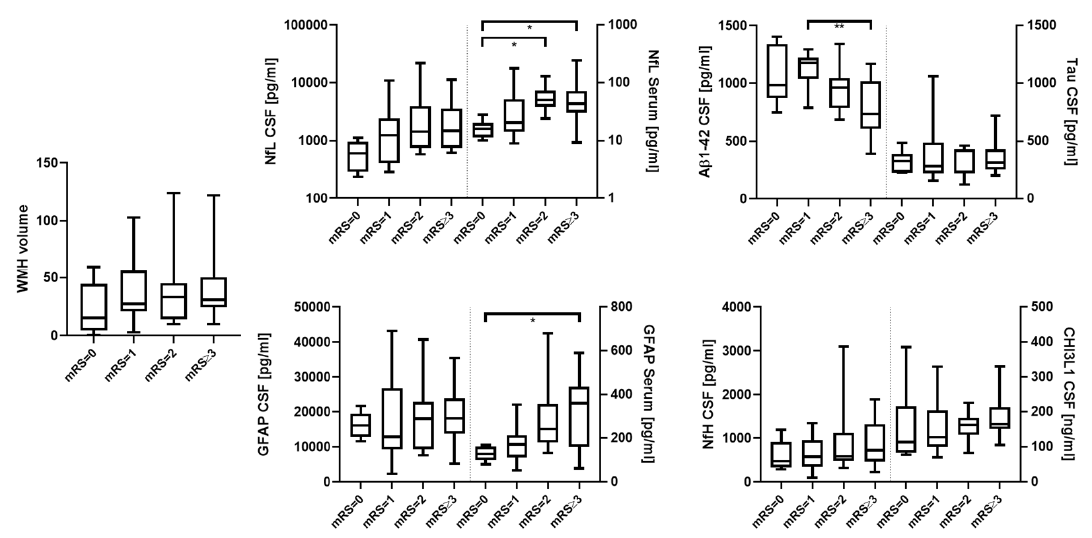
Figure 3. mRS (0, 1, 2 and ≥ 3) compared to WMH, NfL (CSF and serum), GFAP (CSF and serum), A β 1-42 (CSF), Tau (CSF), NfH (CSF) and CHI3L1 (CSF). * = p < 0.05; ** = p <